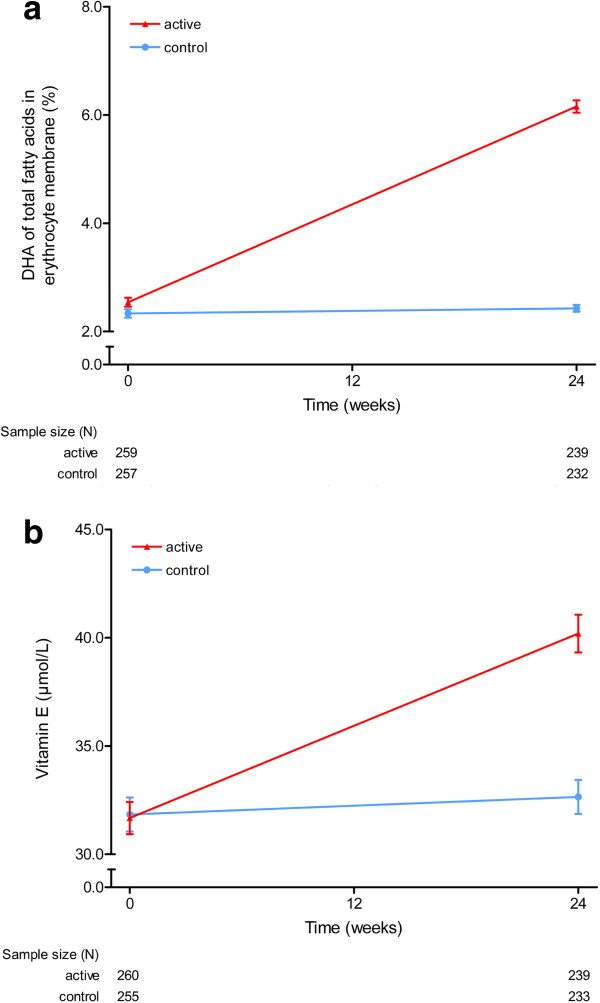
Mean docosahexaenoic acid and plasma vitamin E levels. Effects of 24-week intake of study product on (a) the percentage docosahexaenoic acid (DHA) of total fatty acids in erythrocyte membrane and (b) plasma vitamin E levels (μmol/l) in the intent-to-treat cohort. Error bars represent standard errors. P <0.001 (Mann–Whitney U test).